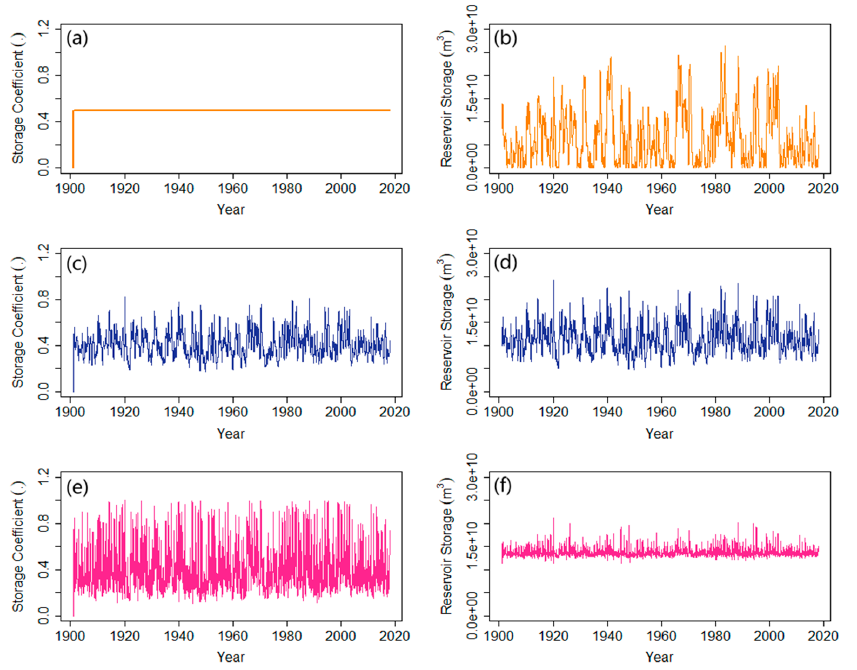
Figure 3. Variation of the storage coefficient ( a , c , e ) and the reservoir storage ( b , d , f ) for three different values of the level of bias β equal to 0 (orange), 1 (blue), and 10 (magenta).